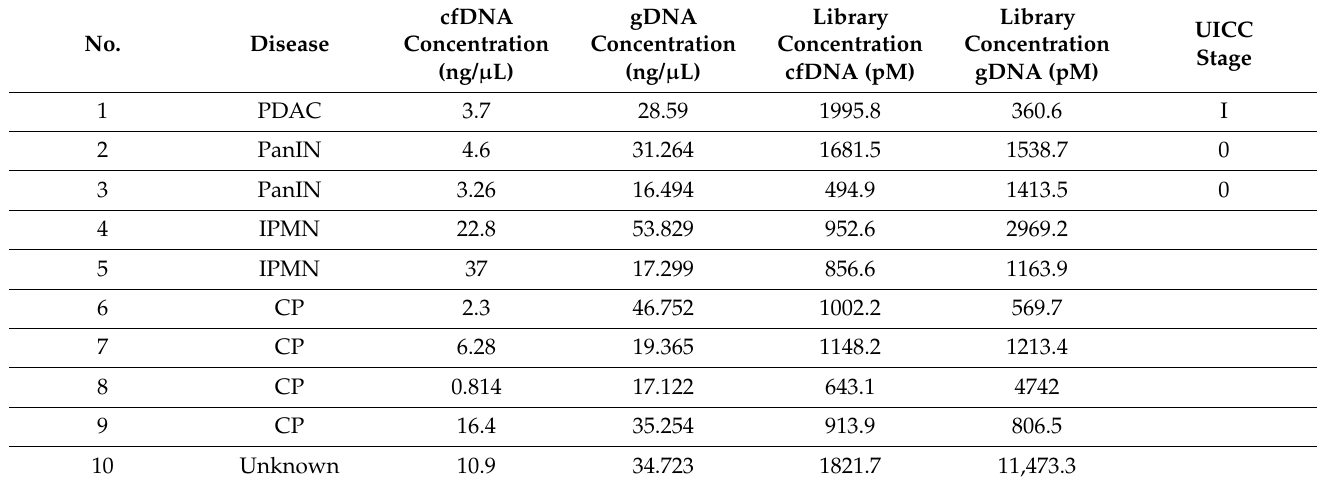
Table 3. Concentrations of cfDNA, genomic DNA (gDNA) and library in the pancreatic juice group.